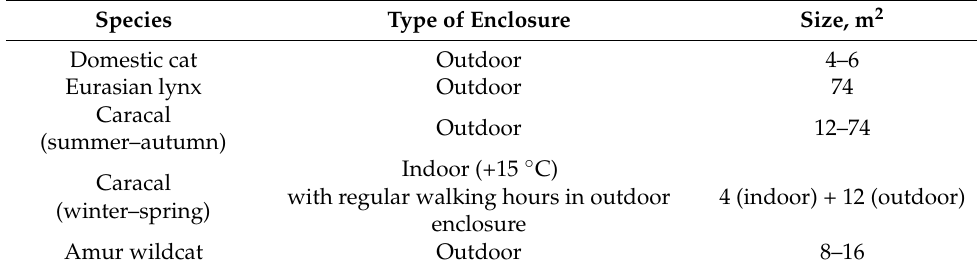
Table 2. The traits of animals’ husbandry conditions. Species Type of Enclosure Size, m 2 Domestic